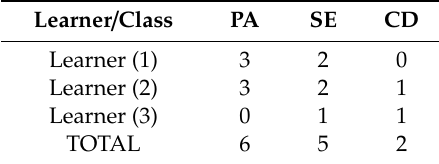
Table 8. Sample of FCS learners’